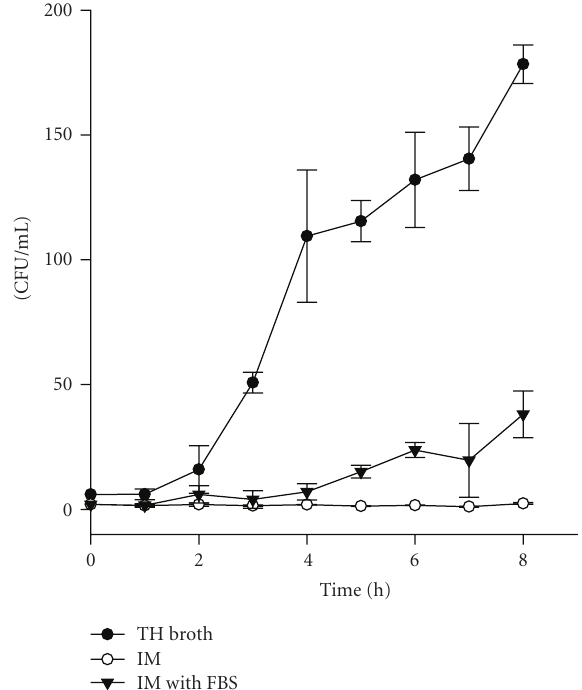
Figure 1: Growth analysis of S. aureus RN6390. To assess growth, S. aureus RN6390 was inoculated into di ff erent media (TH broth, IM, or IM supplemented with FBS). CFUs were determined hourly by a standard plate count method up to 8 hours, and represented as the mean ± SEM of data acquired from three